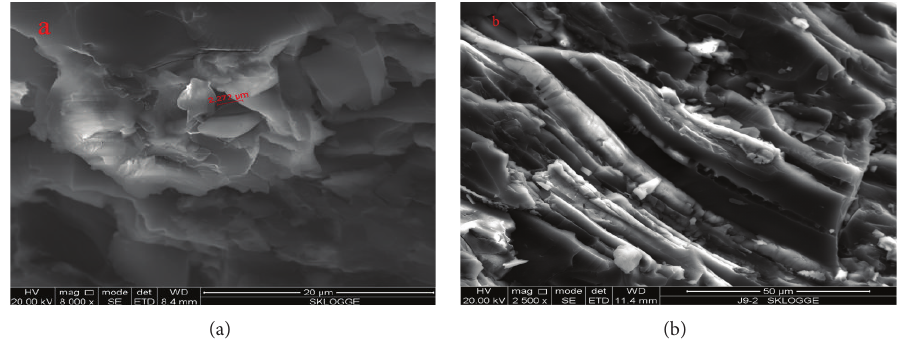
Figure 1: Pore characteristics of coal ((a) micropore; (b) fracture).